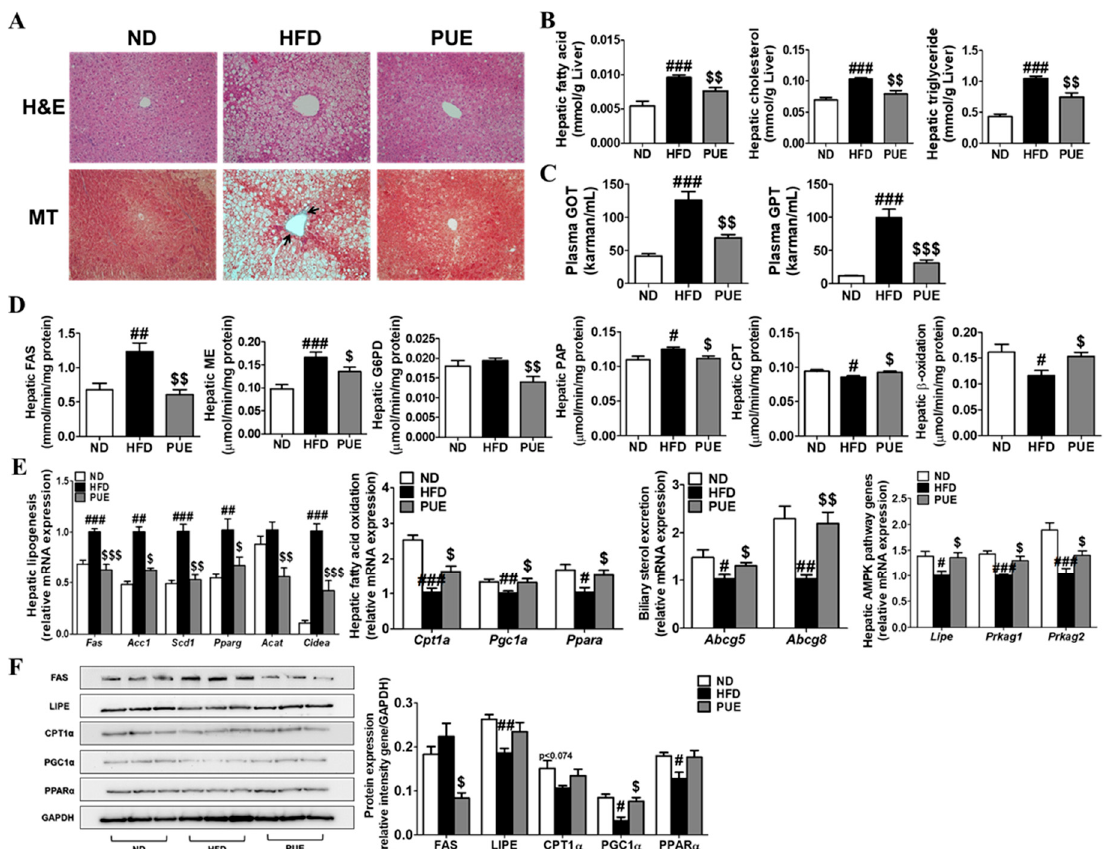
Figure 5. Effect of P. umbrosa root extract on hepatic lipids. ( A ) Hepatic morphology (×200); ( B ) Lev- els of hepatic lipids; ( C ) Hepatotoxicity markers; ( D ) Hepatic lipid-regulating enzyme activities; ( E ) Hepatic gene expression; ( F ) Western blot analysis of FAS, LIPE, PGCLA, CPT1A , and PPARA expression. Data are presented as means ± SEM. ( A ) Arrow indicates fibrosis-positive staining (blue). ( B – F ) Data are presented as means ± SEM.; ND, normal diet (AIN-93G); HFD (60 kcal% fat); PUE, HFD + P. umbrosa root extract (1% w / w ). Significant differences between HFD and ND are indicated: # p < 0.05; ## p < 0.01; ### p < 0.001. Significant differences between HFD and PUE are indicated by $ p